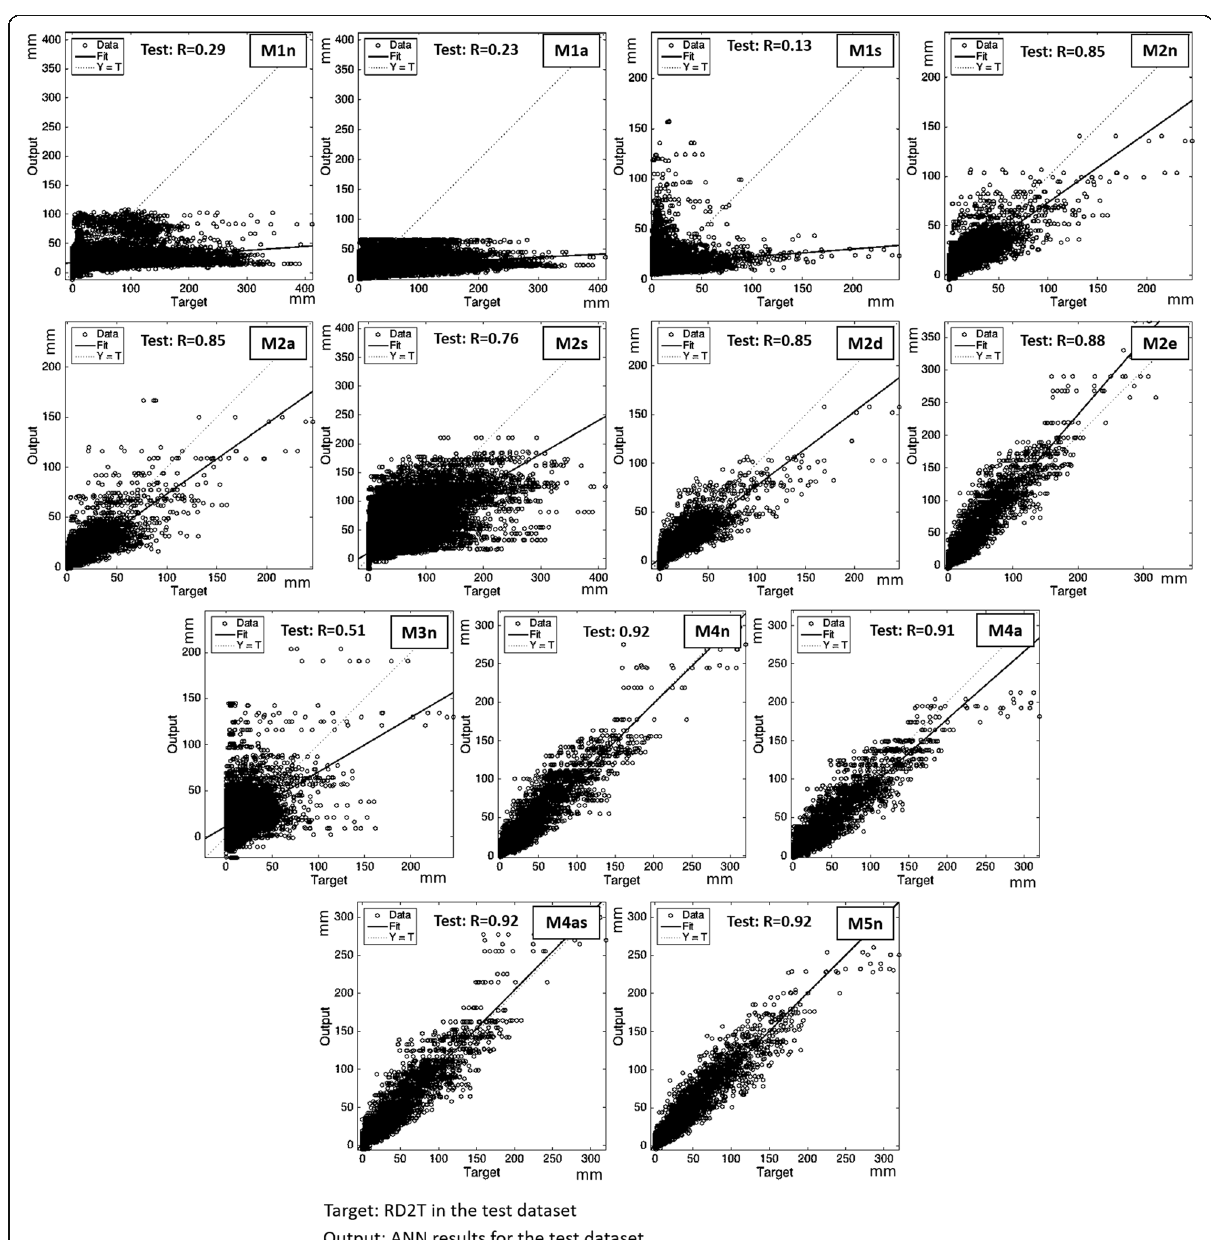
Fig. 5 Correlation coefficients for the ANN model test